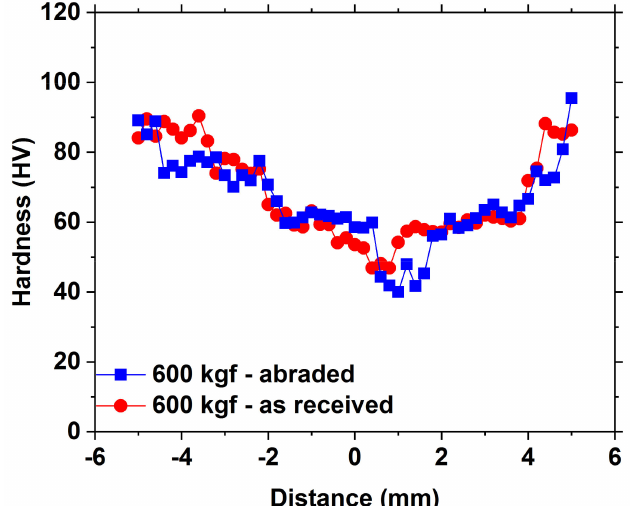
Figure 3. Measured hardness distribution of welds produced at the electrode force of 600